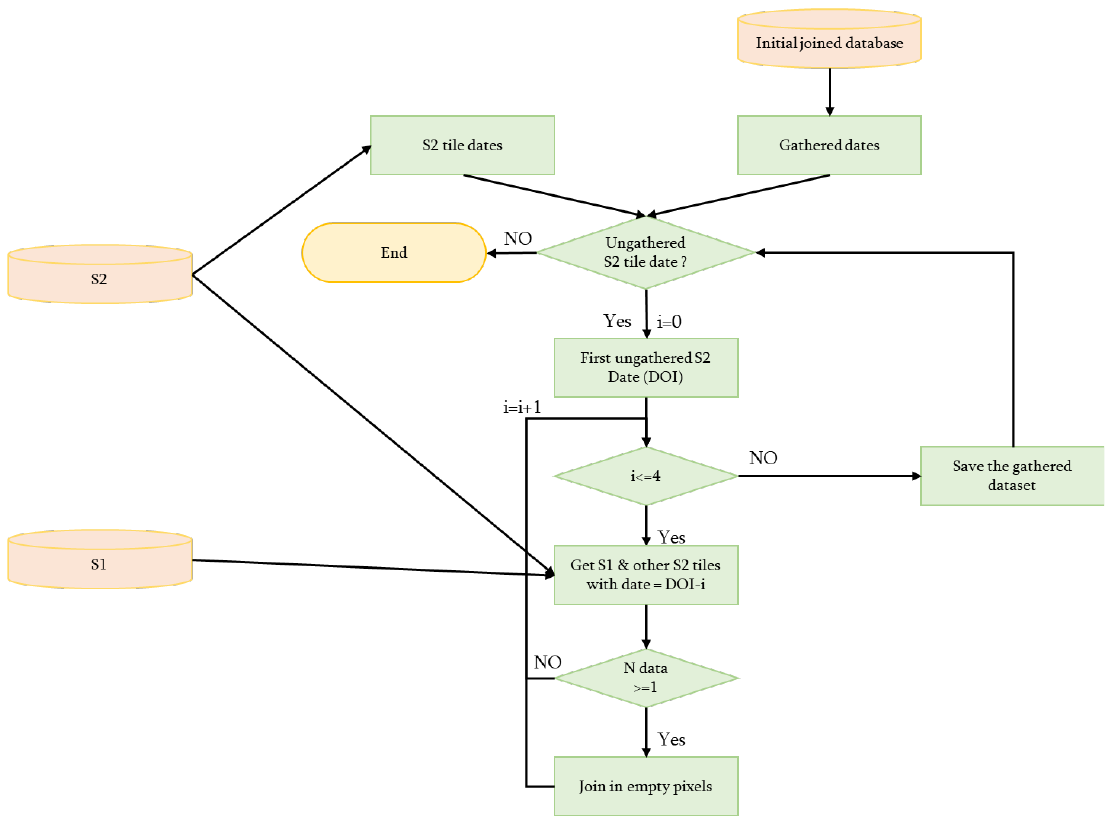
Figure 2. Workflow of the joining process.